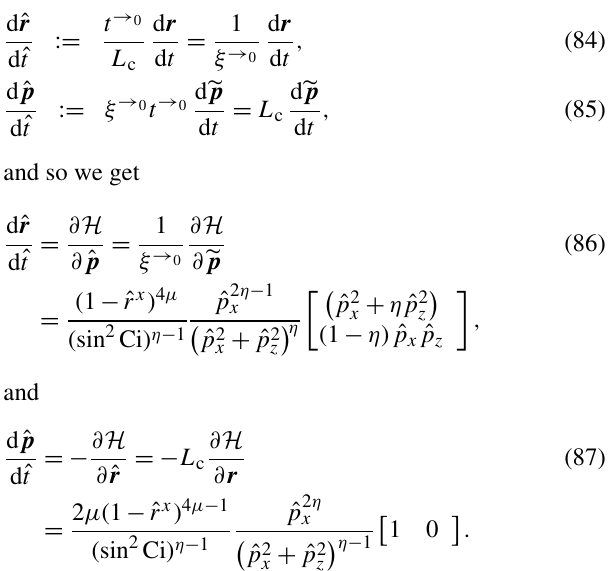
Figure 11 provides a comparison of time-invariant stream profiles for a selection of values of the dimensionless hori- zontal erosion rate Ci ∈ { 0 . 1 ◦ , 1 ◦ , 4 ◦ } . In all other figures il- lustrating numerical solutions, the value of this dimension- less number is set at Ci = 4 ◦